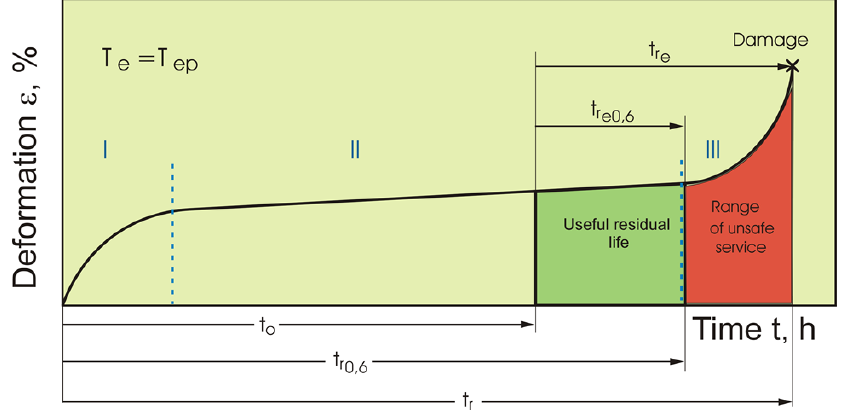
Figure 1. Schematic approach of the definition of residual and disposable durability.